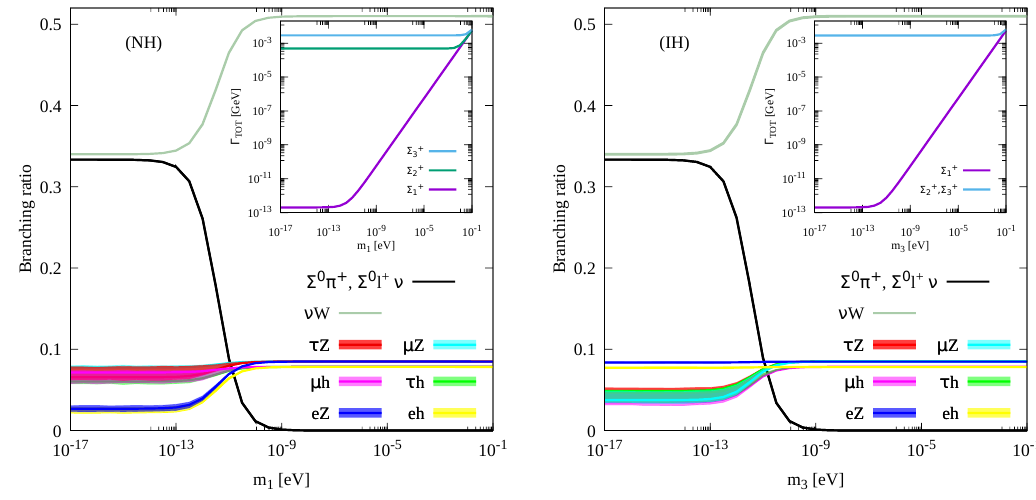
Figure 7 . Average branching ratios for the decay modes of Σ + as a function of m 1 ( m 3 ) for NH(IH). The total decay width ( Γ